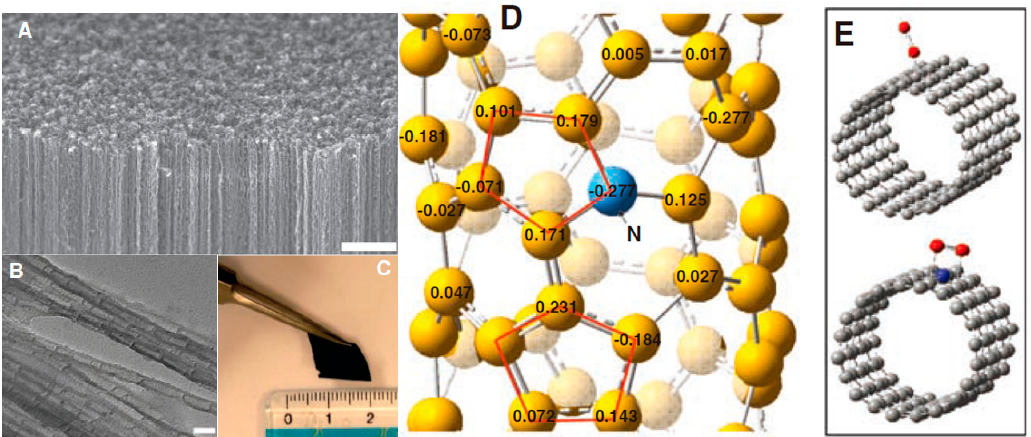
Figure 5. ( A ) The SEM image for showing the side-view of as-prepared VA-NCNTs deposited on a quartz surface. ( B ) The TEM image for showing the morphology of the VA-NCNTs which have been electrochemically purified. ( C ) The digital photograph of the VA-NCNT array after having been transferred onto a conductive nanocomposite film. ( D ) The charge density distribution on the NCNTs according to DFT calculations. ( E ) Sketch for showing the potential chemical adsorption modes of a single oxygen molecule on undoped CNTs (top) and NCNTs (bottom). Reprinted with permission from Ref. [15], 2009, American Association for the Advancement of Science.